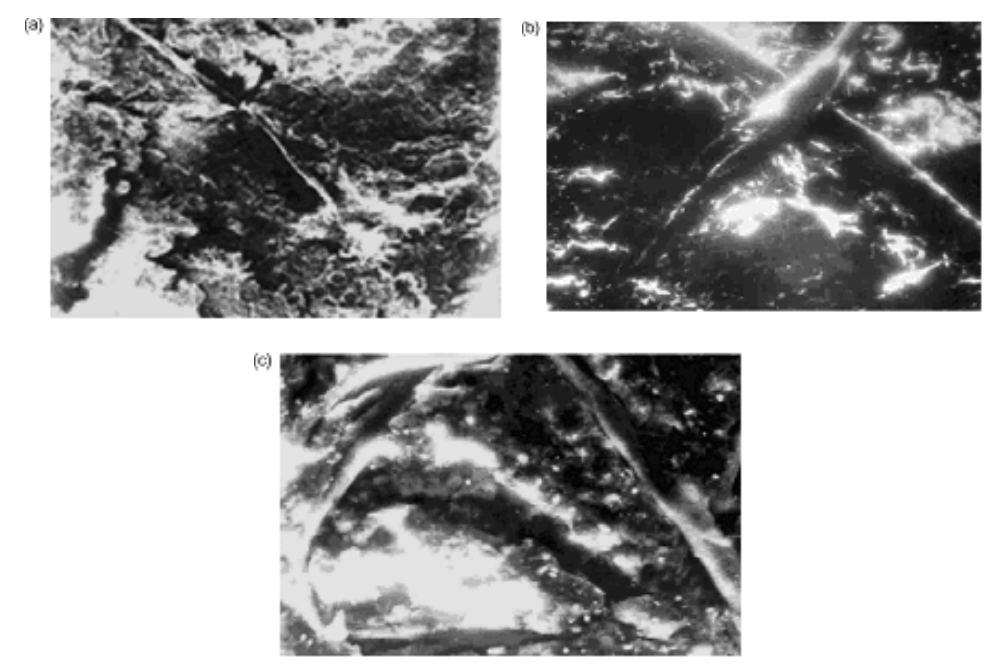
Figure 15. The morphology of the pure polymers SHMPE (a) and iPP (b) ( × 8,000) [23].